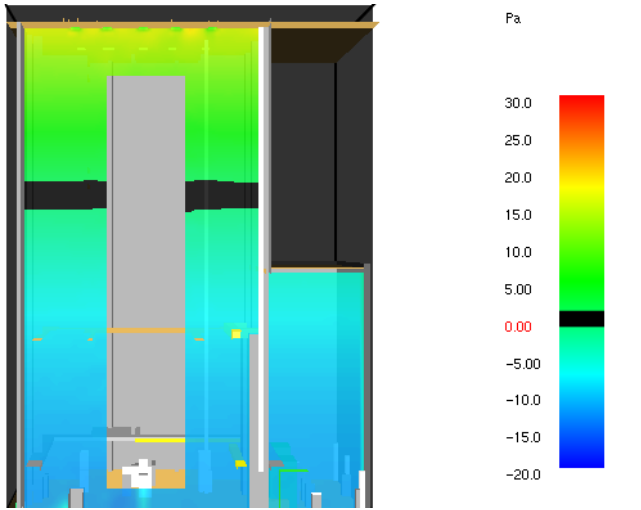
Figure 4. Position of the neutral plane level and pressure distribution in the boiler house under daily operating conditions.